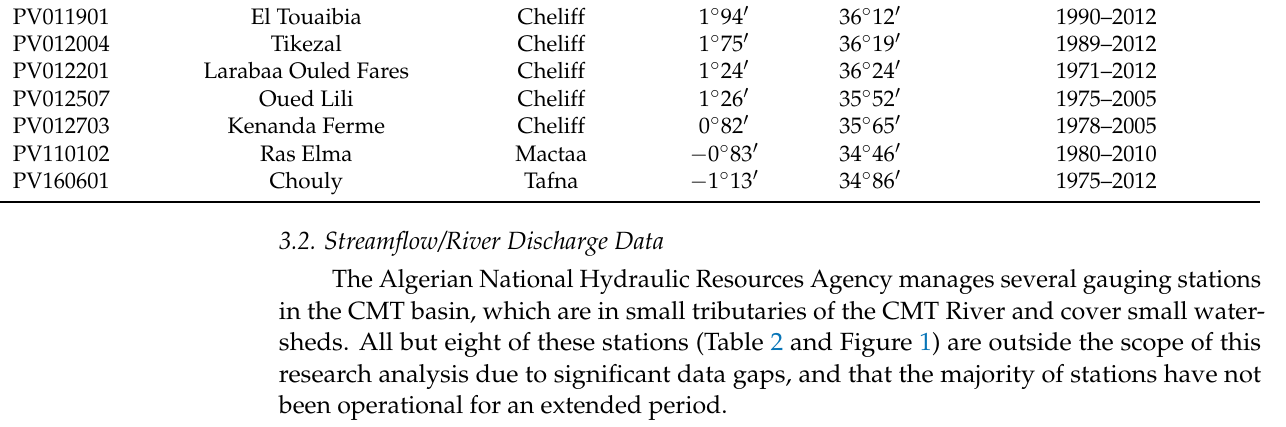
Table 2. Characteristics of hydrometric